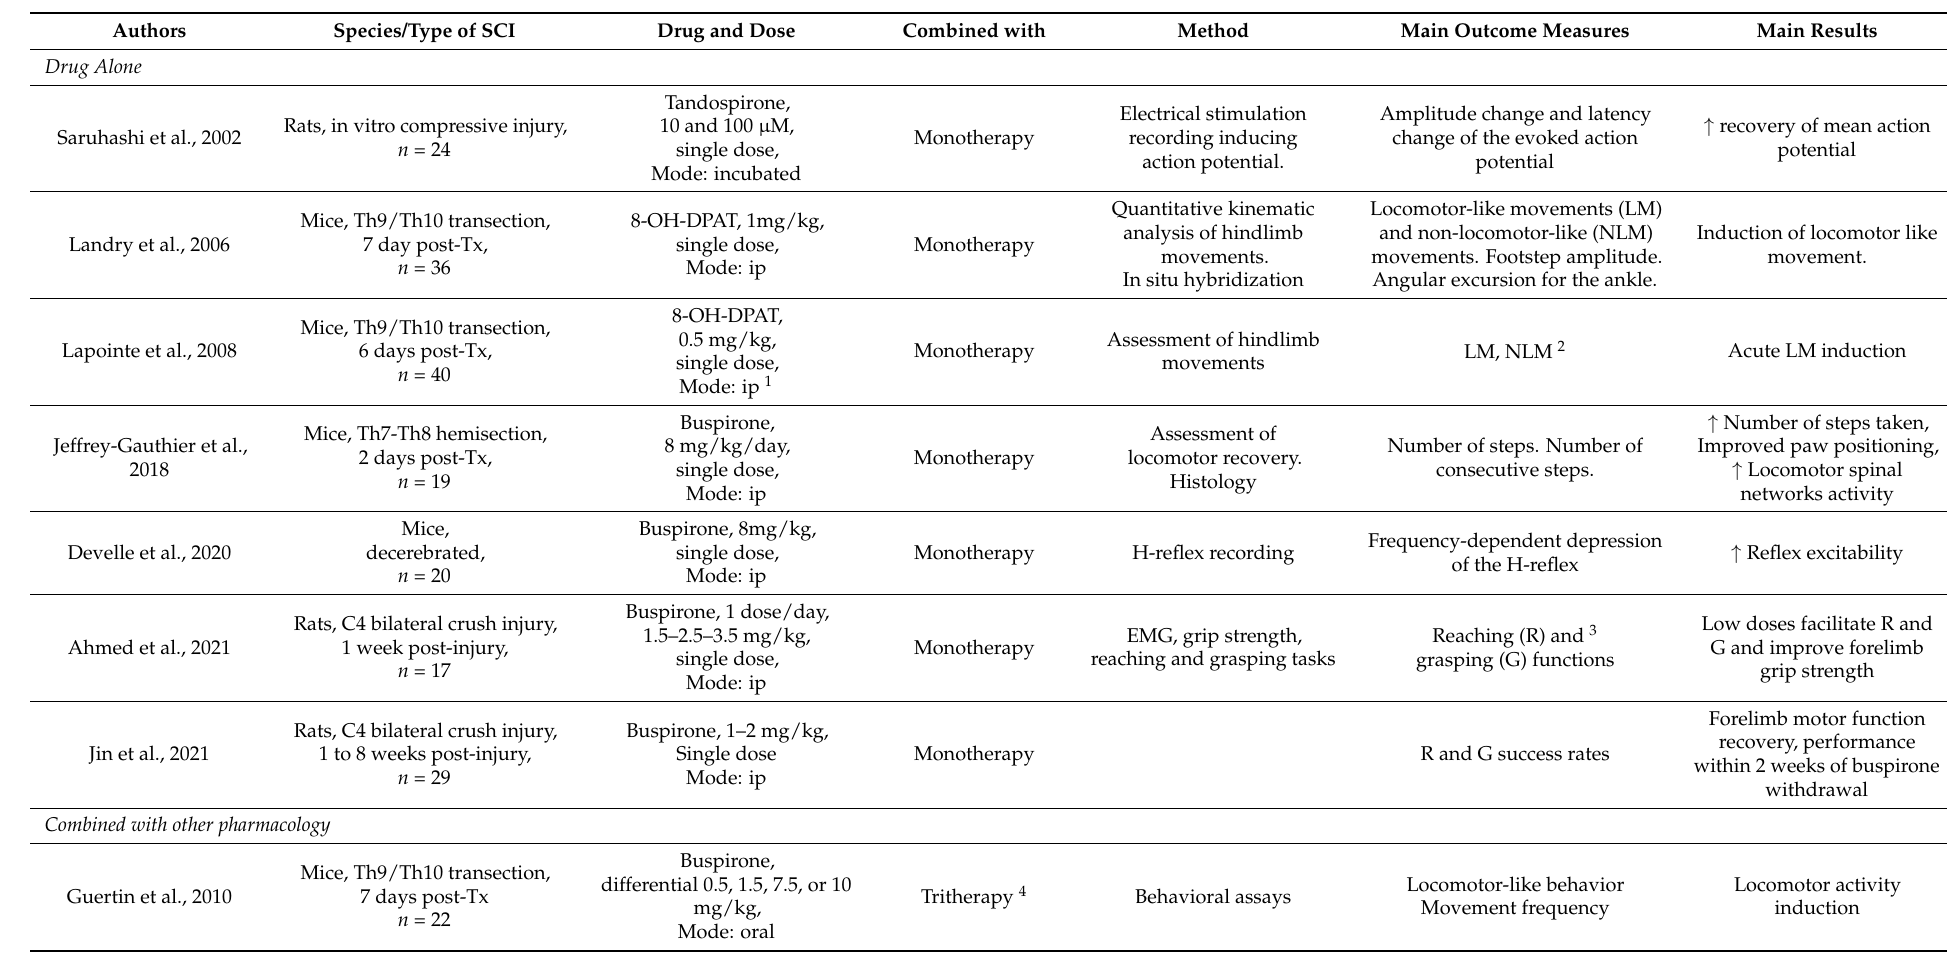
Table 1. Locomotor effects of 5-HT 1A in animal and